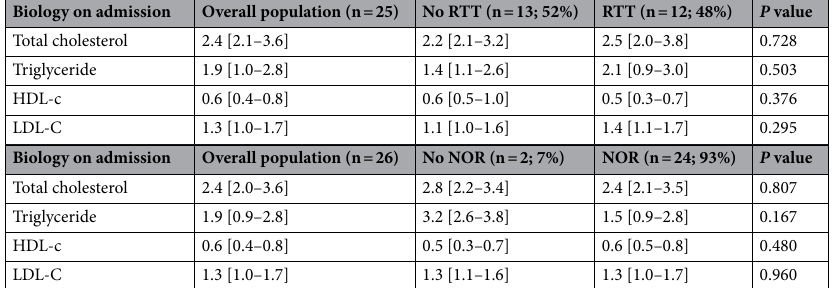
Table 2. Relationship between lipid profile on admission and outcome variables. Variables: renal replacement therapy and need for norepinephrine. Continuous variables are expressed as the median and interquartile range (IQR). RRT: renal replacement therapy; NOR: